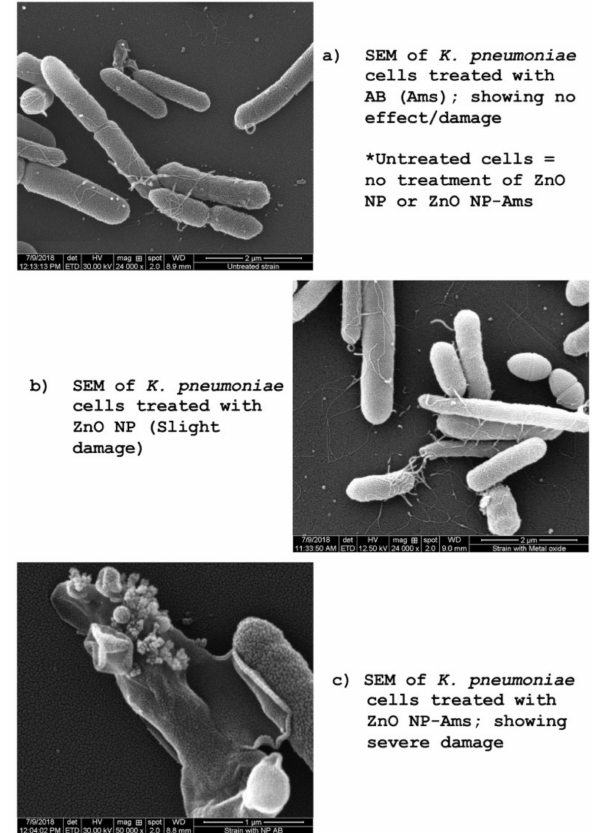
Figure 4. Scanning electron microscopy of treated K. pneumoniae cells: ( a ) SEM of K. pneumoniae cells treated with Ams (AB); showing no e ff ect / damage; ( b ) SEM of K. pneumoniae cells treated with ZnO NP; slight damage; ( c ) SEM of K. pneumoniae cells treated with ZnO NP–Ams (AB); showing severe damage. Note: *Untreated strain = no treatment of Ams, ZnO NP, or ZnO